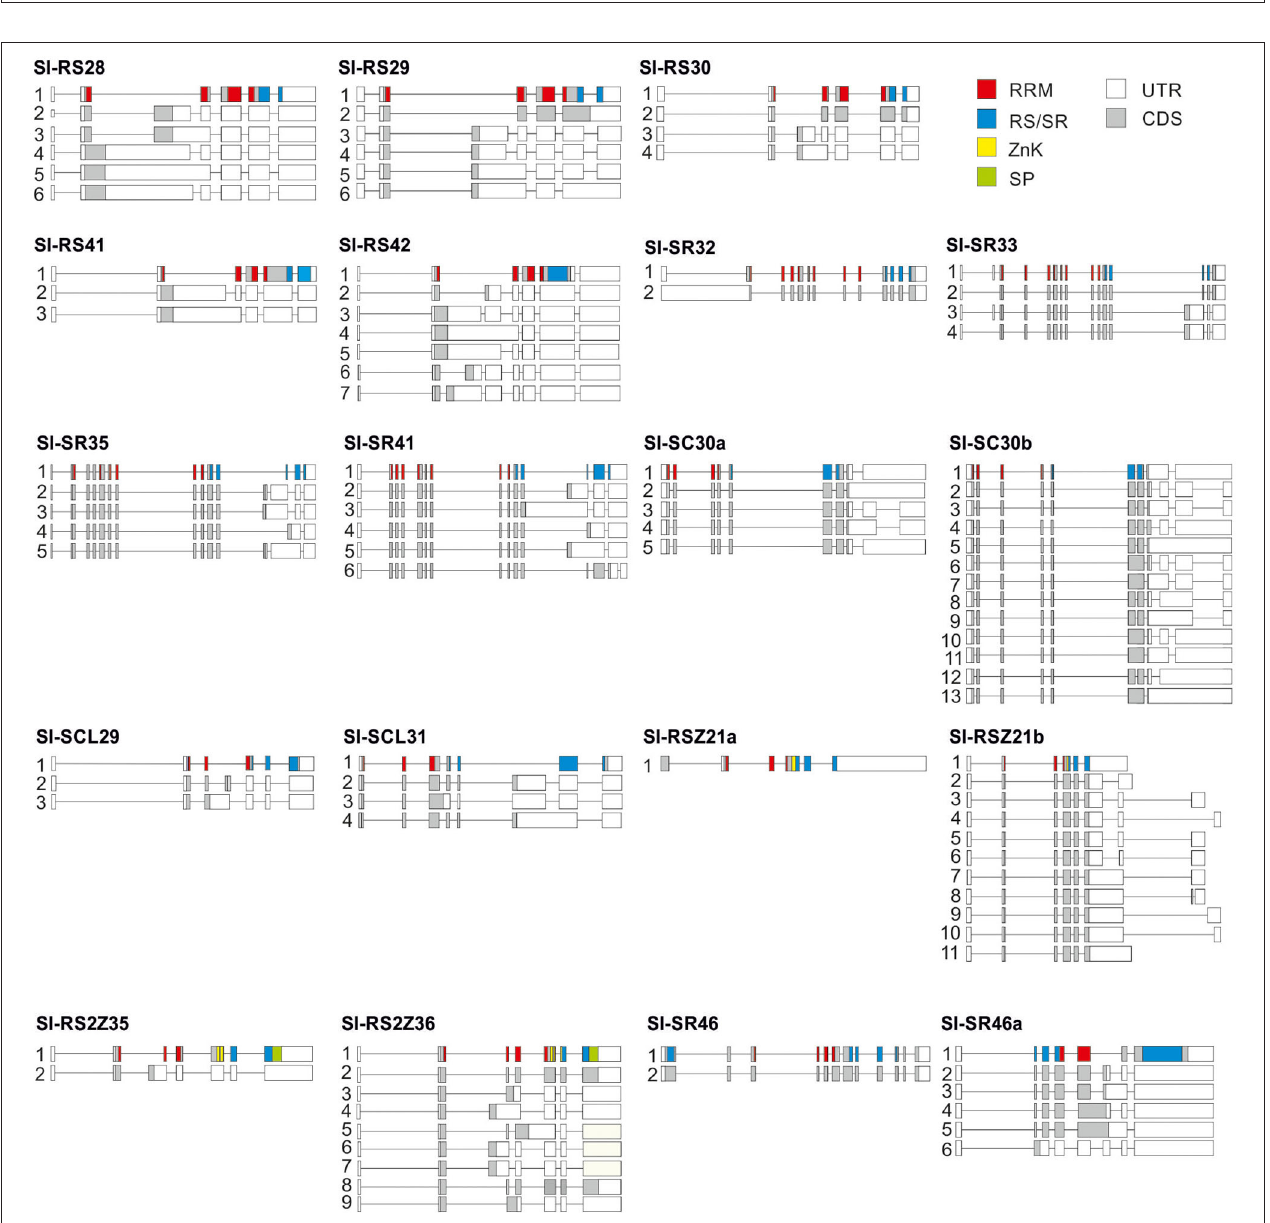
FIGURE 3 | Zouine et al., 2017). (B) Heat map depicting the relative transcript abundance of tomato SR genes in selected tomato organs based on qRT-PCR analysis. The dendrogram was generated by hierarchical clustering of genes based on Pearson distance of z-score data and average linkage using heatmapper (Babicki et al., 2016). – 11 Ct values after normalization with CAC and EF1 α housekeeping genes and leaf as calibrator sample were used. In (A) RSZ21a transcript levels correspond to Solyc08g006430; in (B) gene specific oligonucleotides for Solyc08g006435 amplification were used. Fruit stages: IG, immature green with 50% diameter of the mature green; MG, mature green; TU, turning; RR, red ripe.